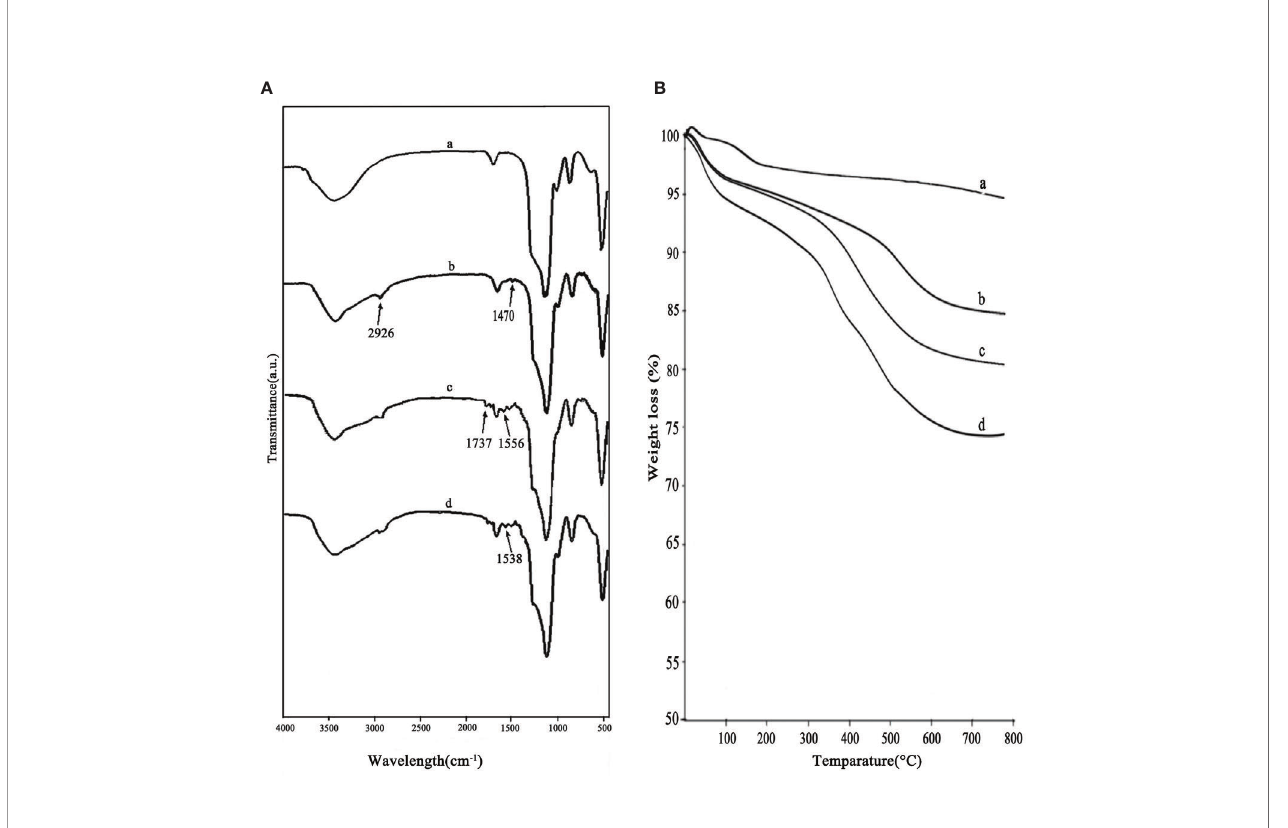
FIGURE 3 | FTIR spectra (A) and thermograms (B) of MSNs (a), MSNs-NH 2 (b), MSNs-NH 2 -FA (c), and MSNs-NH 2 -FA-RGD (d).